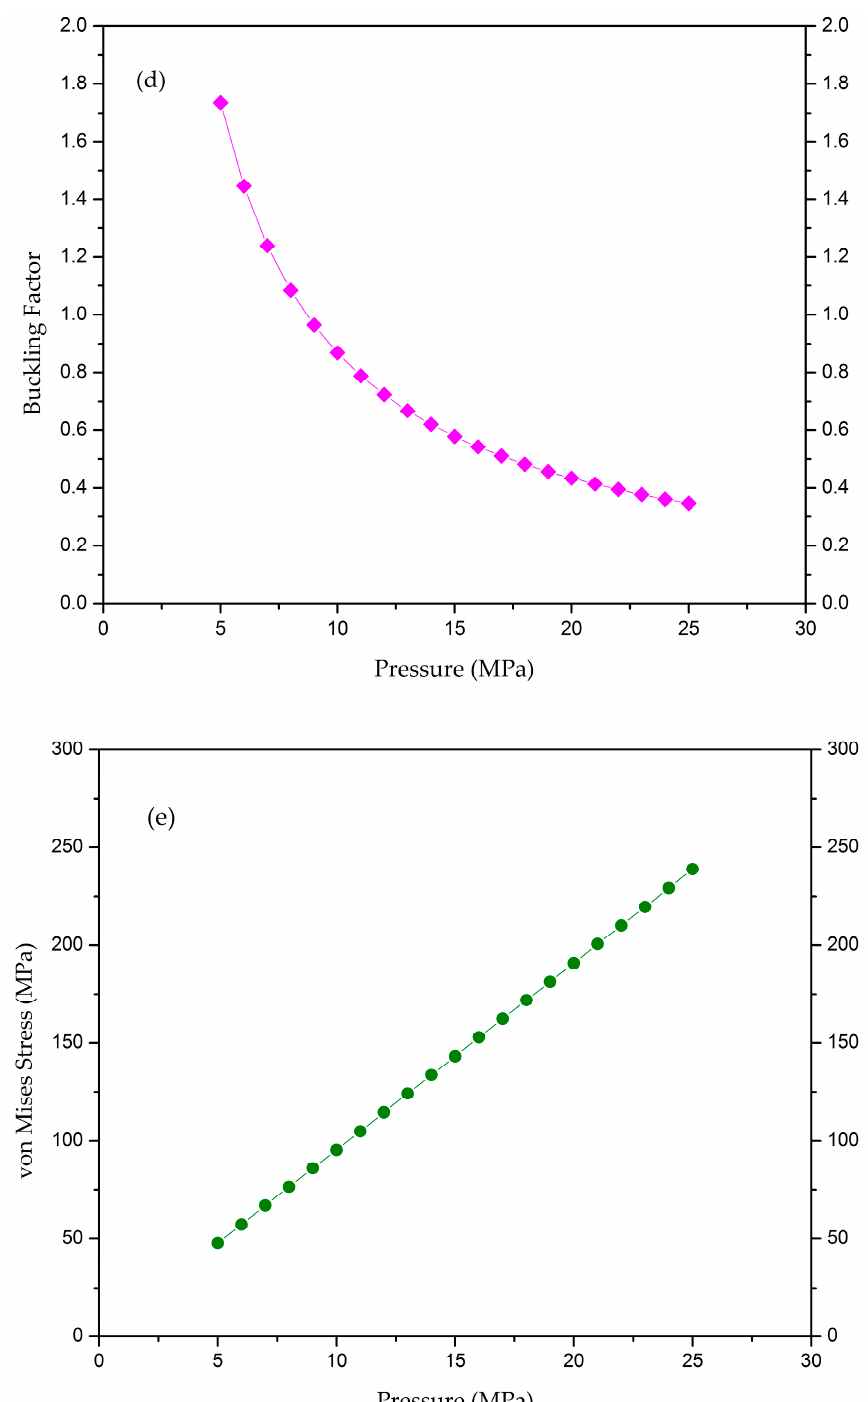
Figure 3. ( a ) Graph of total deformation vs. pressure; ( b ) graph of Tsai-Wu safety factor vs. pressure; ( c ) graph of Tsai-Hill safety factor vs. pressure; ( d ) graph of eigenvalue buckling vs. pressure; ( e ) graph of von Mises stress vs. pressure.